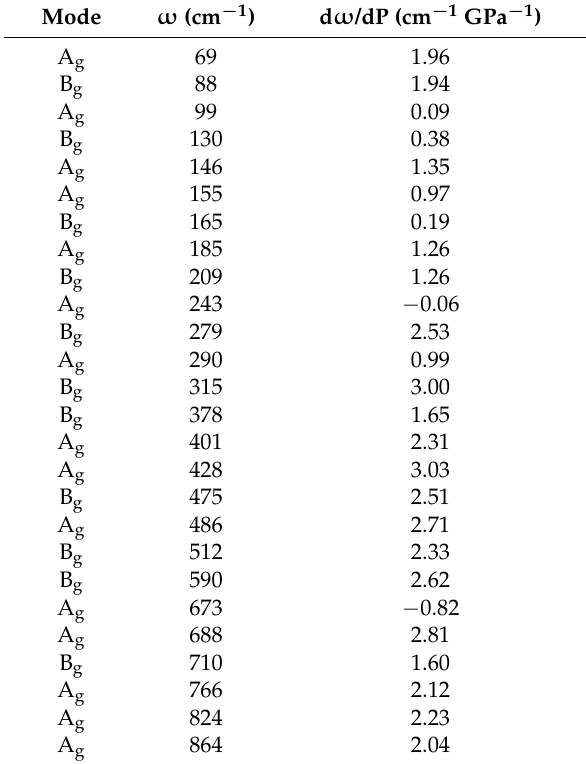
Table 4. The Raman-active modes of the HP phase of CdWO 4 at 26.9 GPa with their pressure coefficients. Twenty-six out of the 36 modes expected were